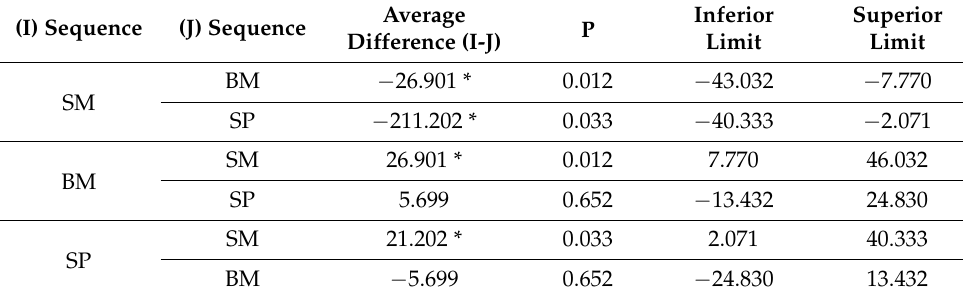
Table 10. Tukey Test — Multiple comparisons between the sequences.